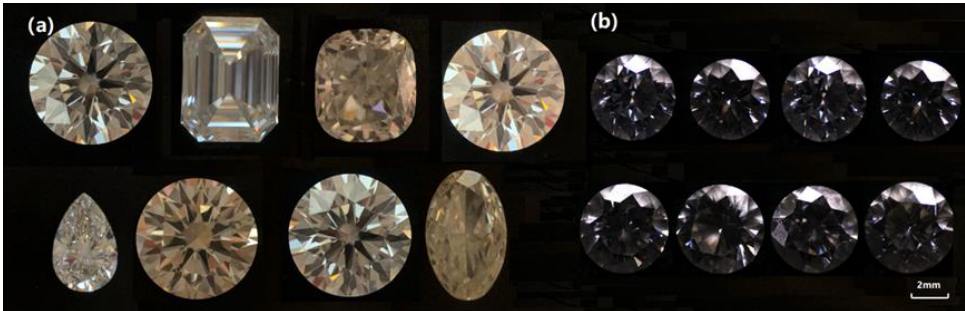
Figure 1. Appearance of diamond samples ( a ): CVD diamonds and ( b ): natural diamonds.